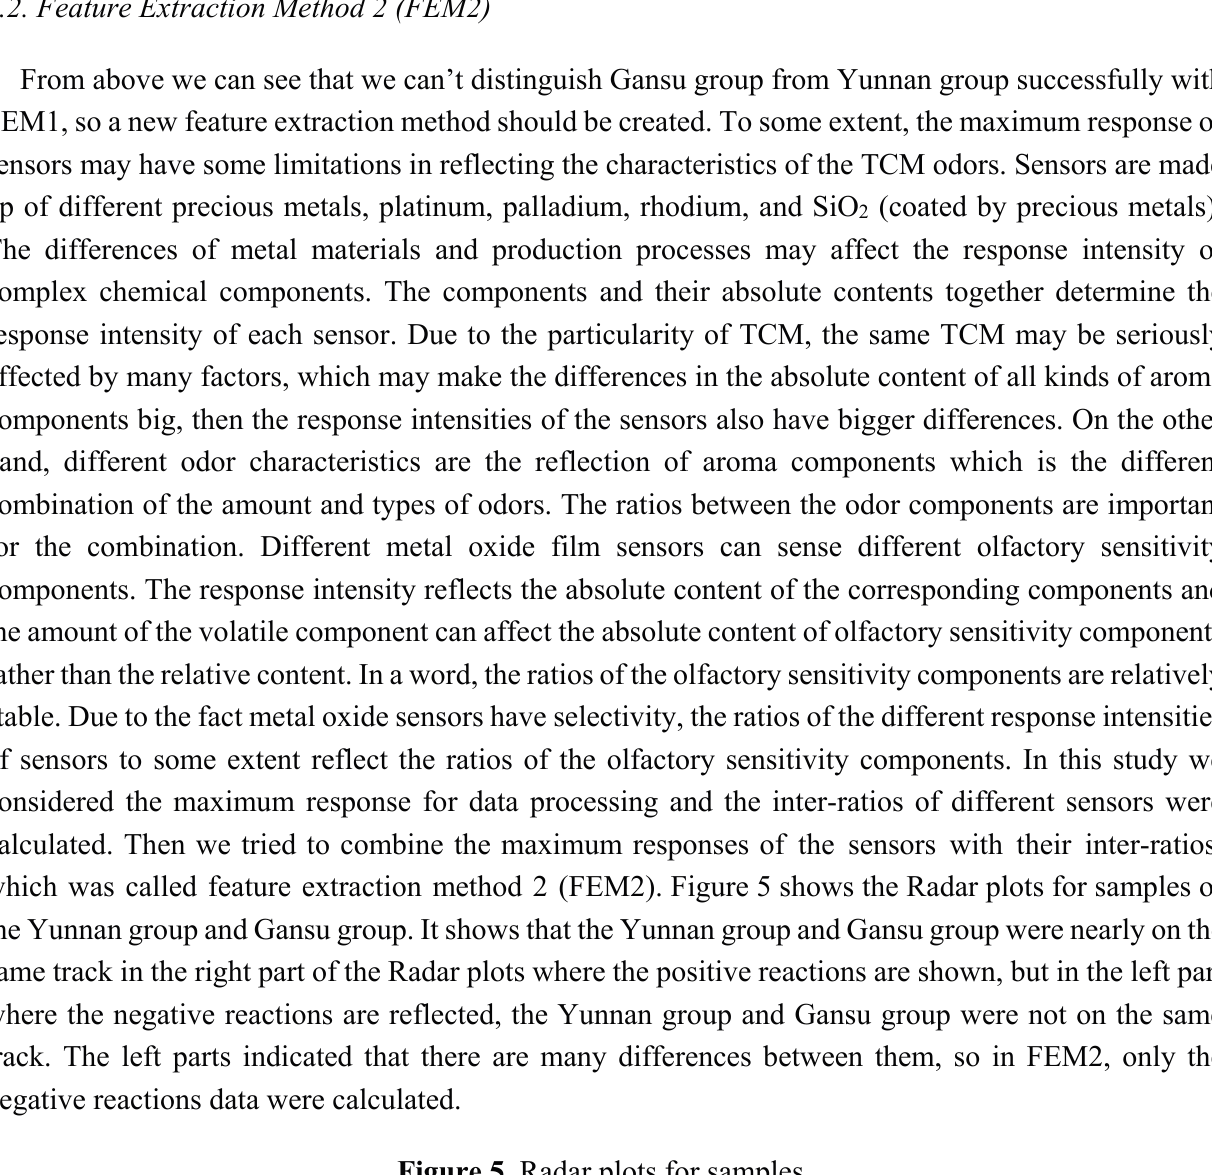
Figure 5. Radar plots for